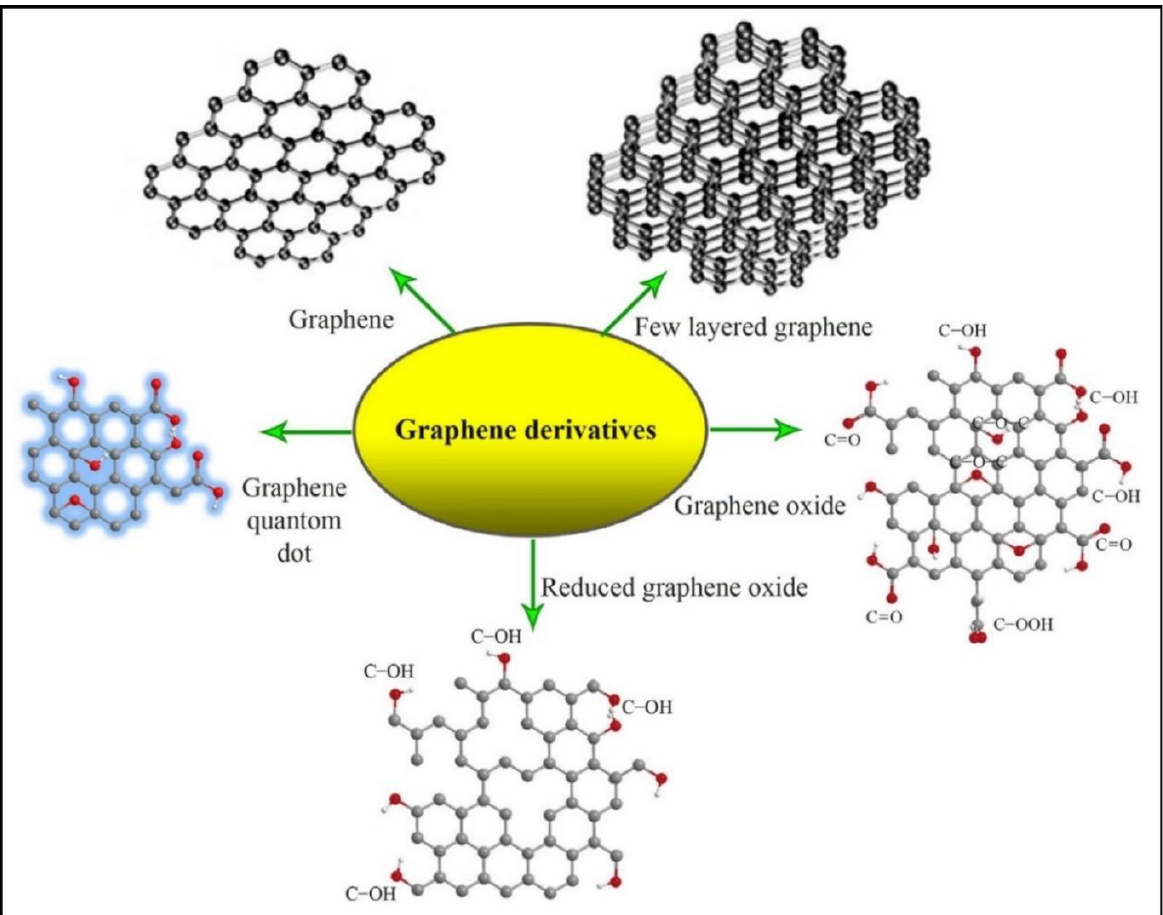
Figure 2. Schematic illustration of various structures of graphene derivatives. Reprinted with permission from Ref. [21].